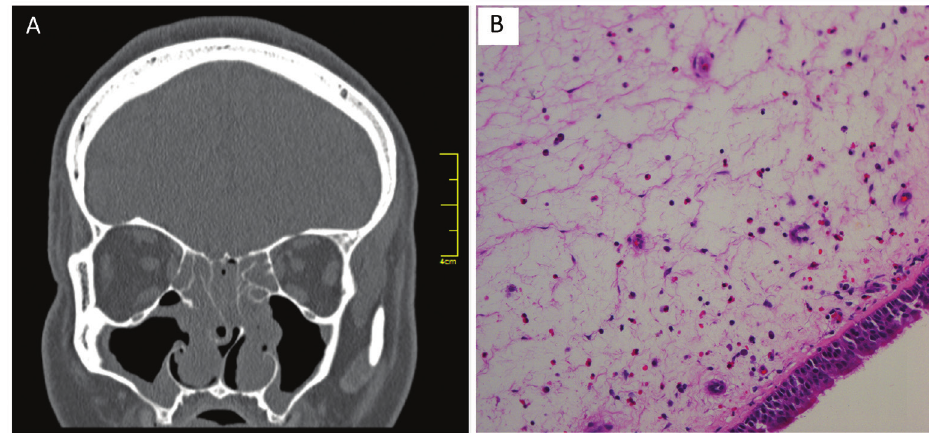
Figure 1 A, Computed tomography of the paranasal sinuses. Coronal section showing the polyps occupying the nasal cavities bila- terally, with opacification of the ethmoid sinuses due to retention of secretion and insertion of antrochoanal polyps in the medial wall of the maxillary sinuses bilaterally. B, Histological photograph at a 100 × magnification stained with hematoxylin and eosin, demonstrating antrochoanal polyp with pseudostratified cylindrical epithelium, discreet superficial inflammatory infiltrate, and occasional